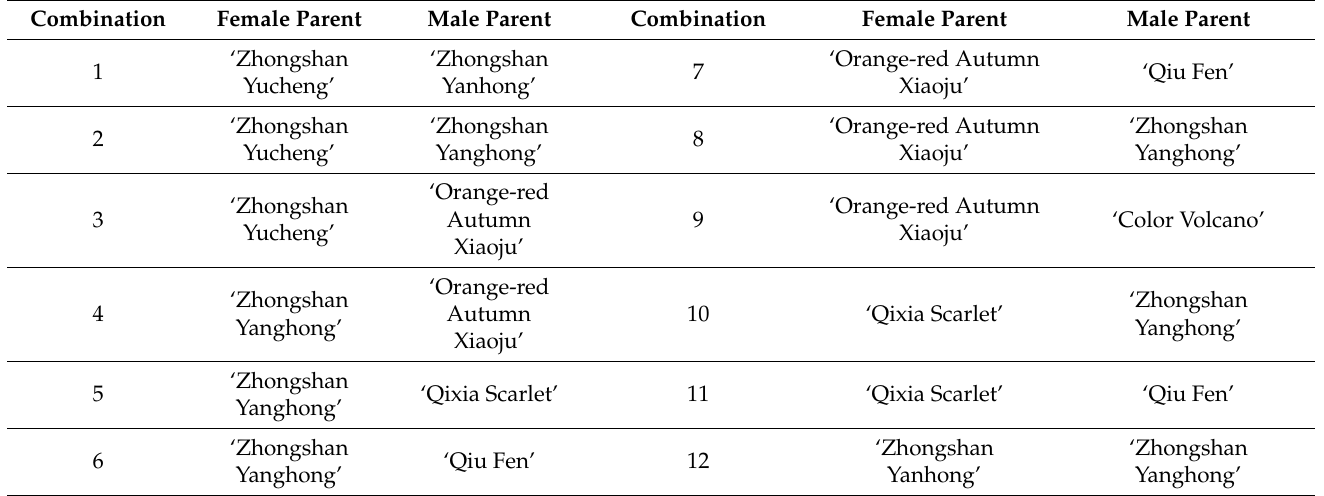
Table 1. Match of combination.